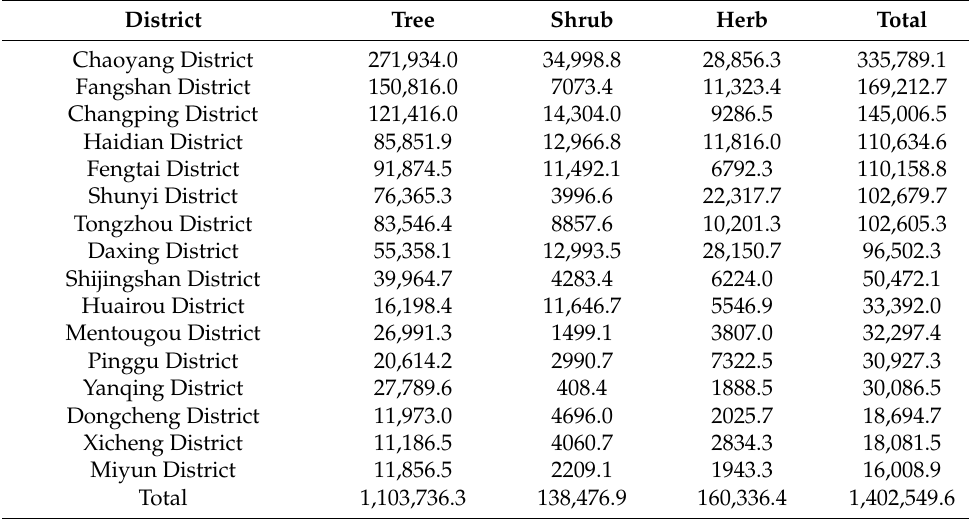
Table 15. Annual water consumption of trees, shrubs and herbs in Beijing (10 3 m 3